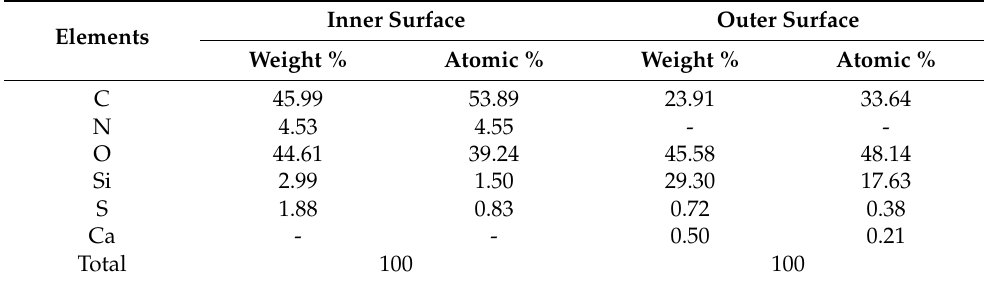
Figure 2. SEM images of inner and outer surfaces of rice husk. ( a ) Inner surface (100× magnification), ( b ) inner surface (500×), ( c ) outer surface (100×), ( d ) outer surface (500×). Table 2. Elemental weights and atomic percentages of the inner and outer surfaces from EDX spectra of rice husk.